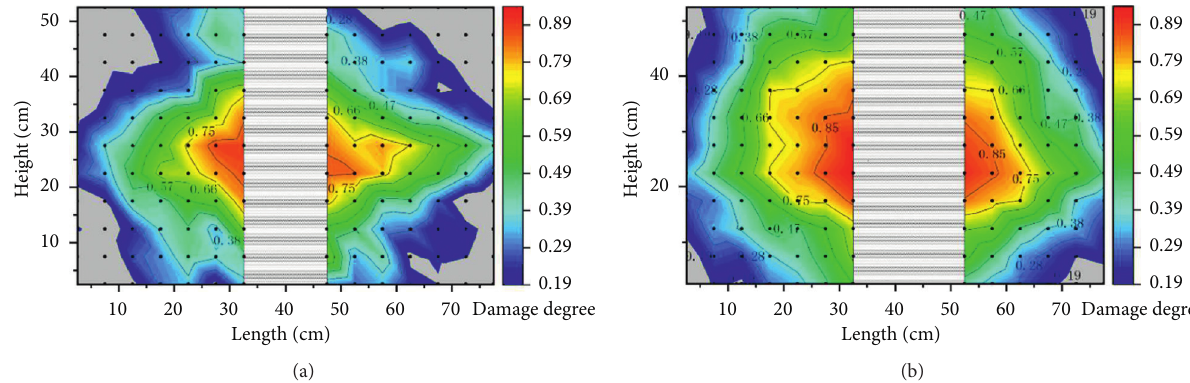
Figure 11: Damage degree after blasting: (a) conventional blasting; (b) multidirectional shaped charge blasting.